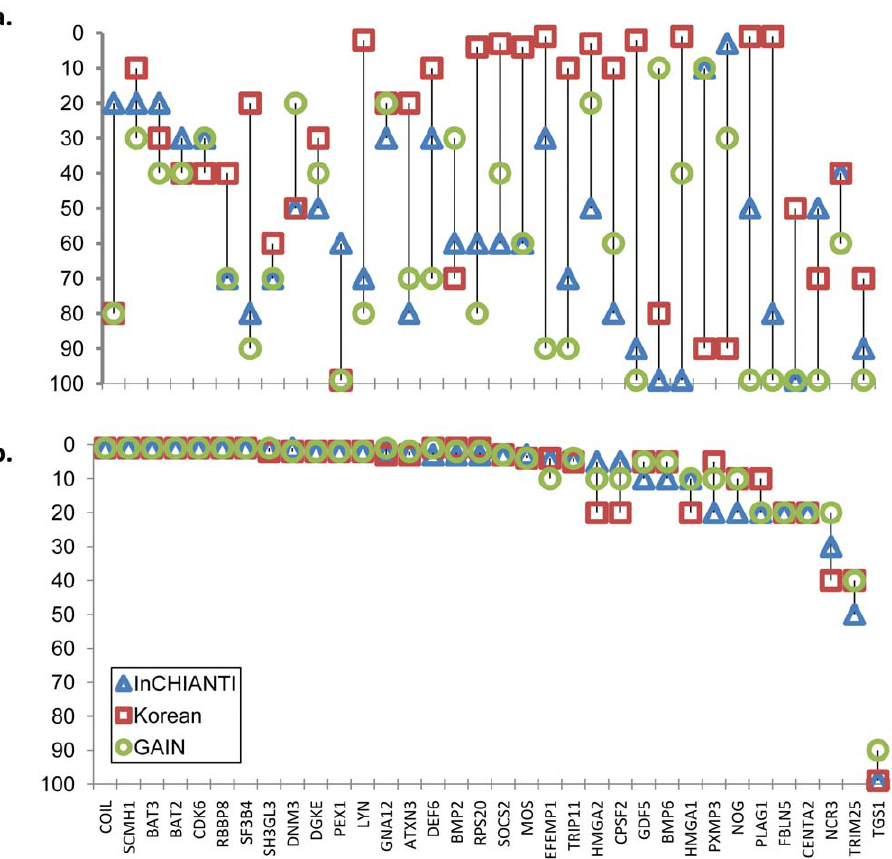
Figures 2. Comparison of gene-based percentile ranks with NIMMI’s network percentile ranks. The x-axis shows the candidate genes for height and the y-axis shows the percentile rank. Blue triangles represent the InCHIANTI GWAS dataset, red squares represent the Korean height GWAS dataset and green circles represent the GAIN Controls height GWAS dataset. Figure 2a shows the single-locus ranking and Figure 2b shows NIMMI network-based ranking for 34 height candidate genes. Table S2. A maximum of two significant Gene Ontology (GO) terms generated by DAVID are shown, along with the specific GO term, the number of genes associated with that GO term, and the corrected gene-set enrichment p-value (see Methods for GO term selection criteria). For example, one sub-network includes a total of 129 genes, of which 76 genes are involved in gene expression and 56 are involved in nucleic acid metabolism. Nineteen of the 38 sub-networks prioritized by NIMMI were significantly enriched for genes involved in nucleic acid metabolism. Eight sub-networks were enriched for genes that regulate gene expression and 12 sub-